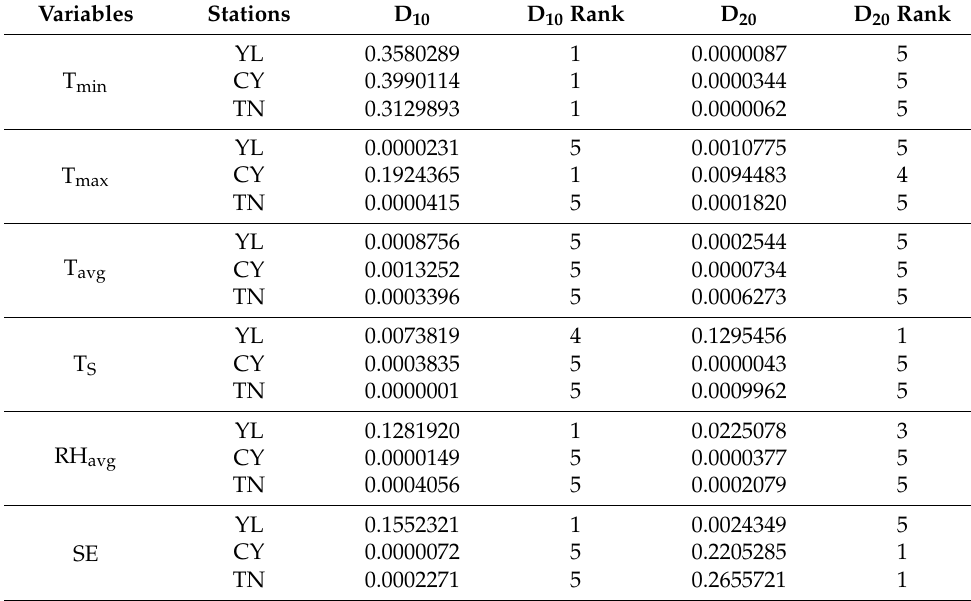
Table 8. Sensitivity analysis results and ranked result of the PNN model.